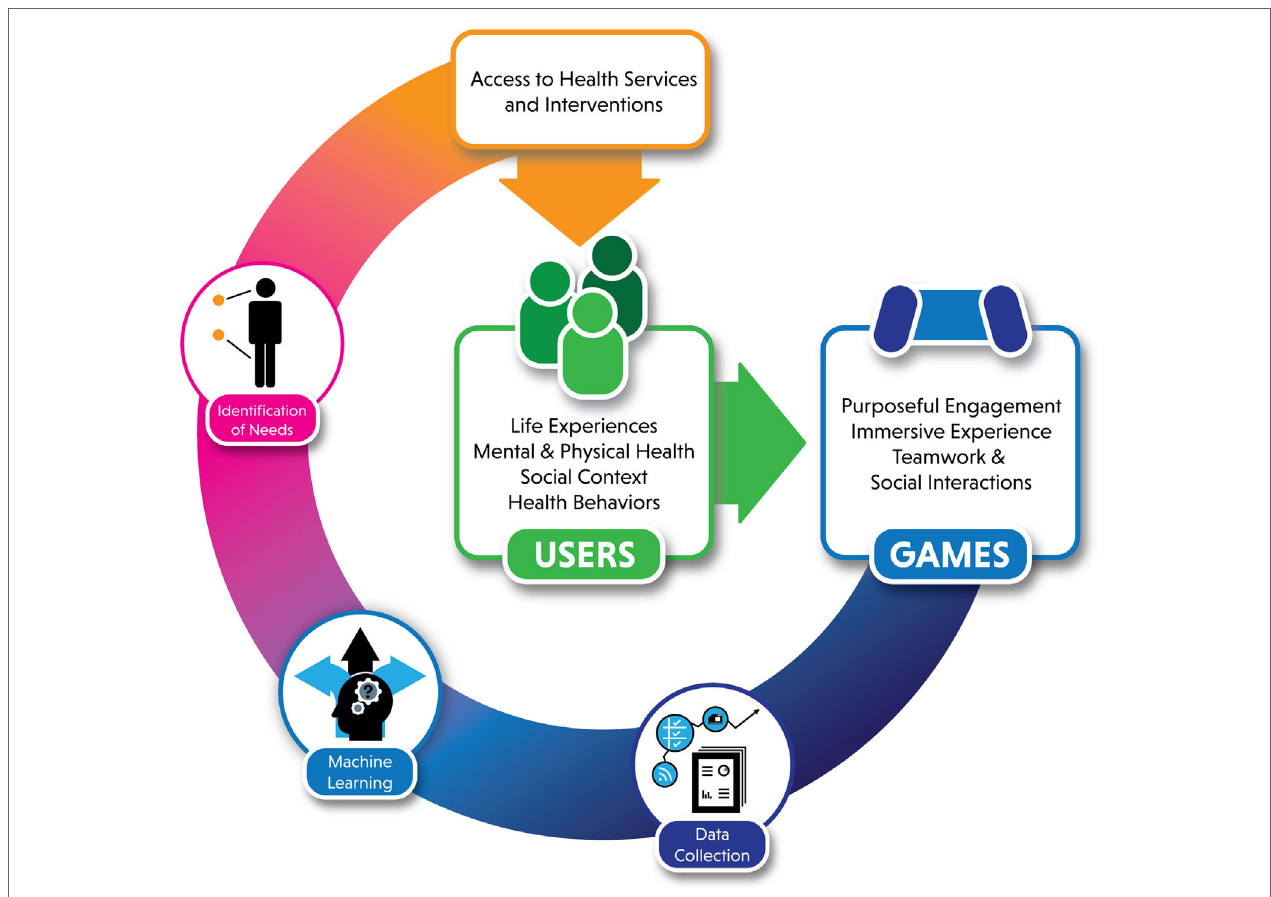
FiGURe 1 | Conceptual framework for video games as